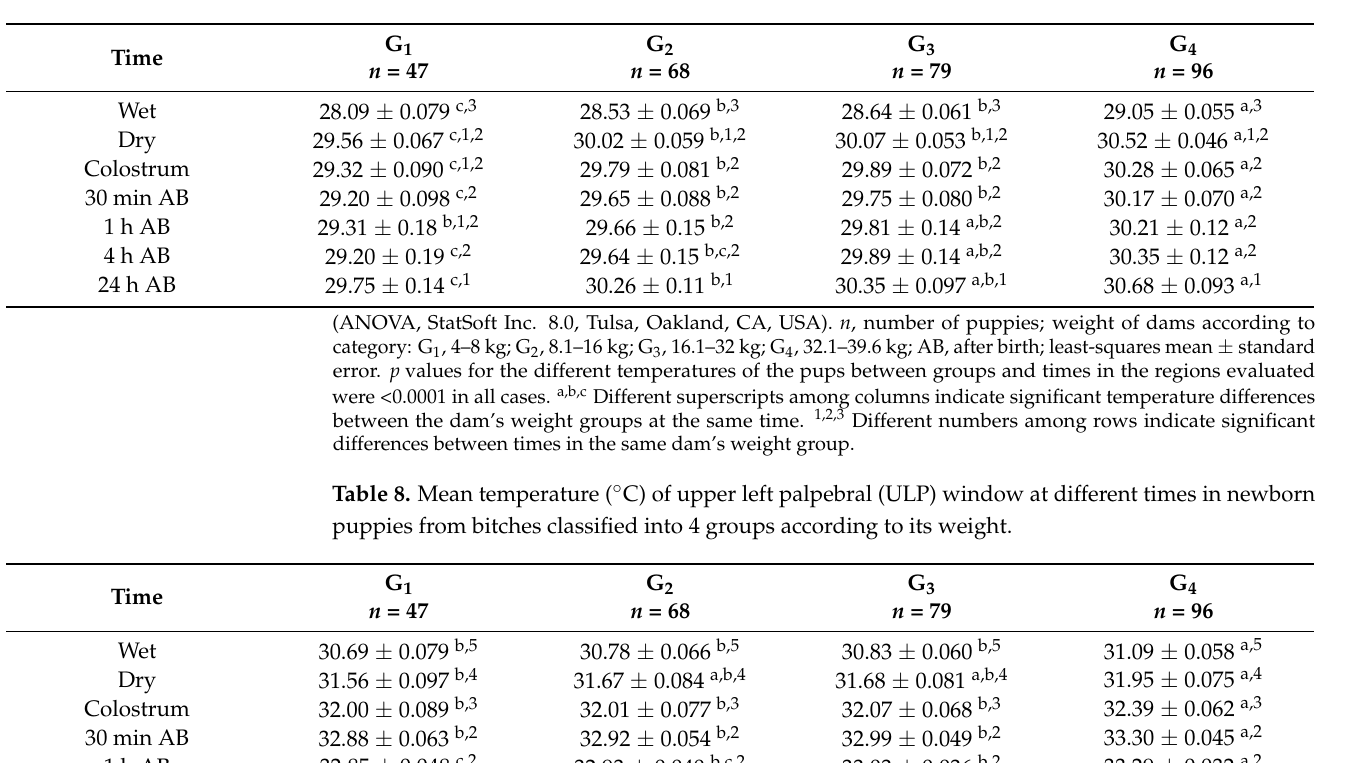
Table 7. Mean temperature ( ◦ C) of nasal (N) window at different times in newborn puppies from bitches classified into 4 groups according to its weight.